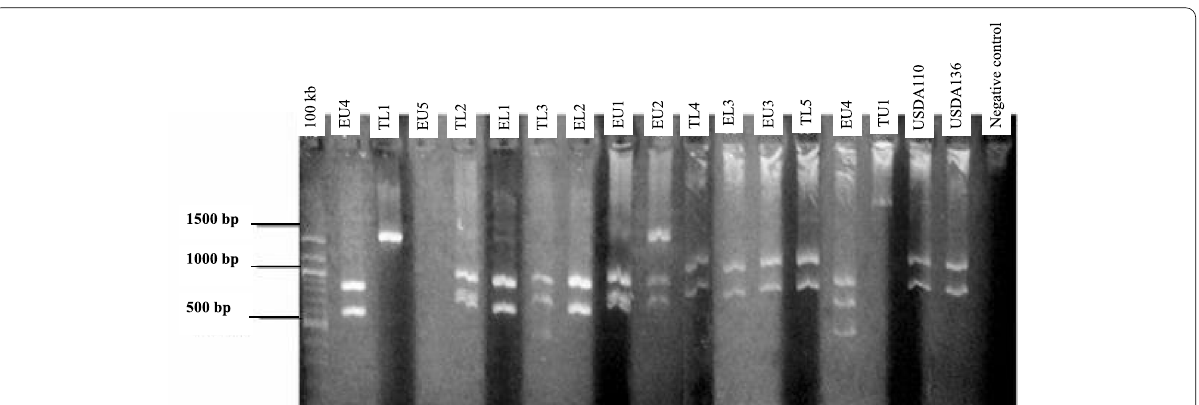
Fig. 3 Restriction fragments for bradyrhizobia isolates obtained after digestion with the Eco RI enzyme on 1.4% agarose gel, and the DNA was stained with SYBR green dye